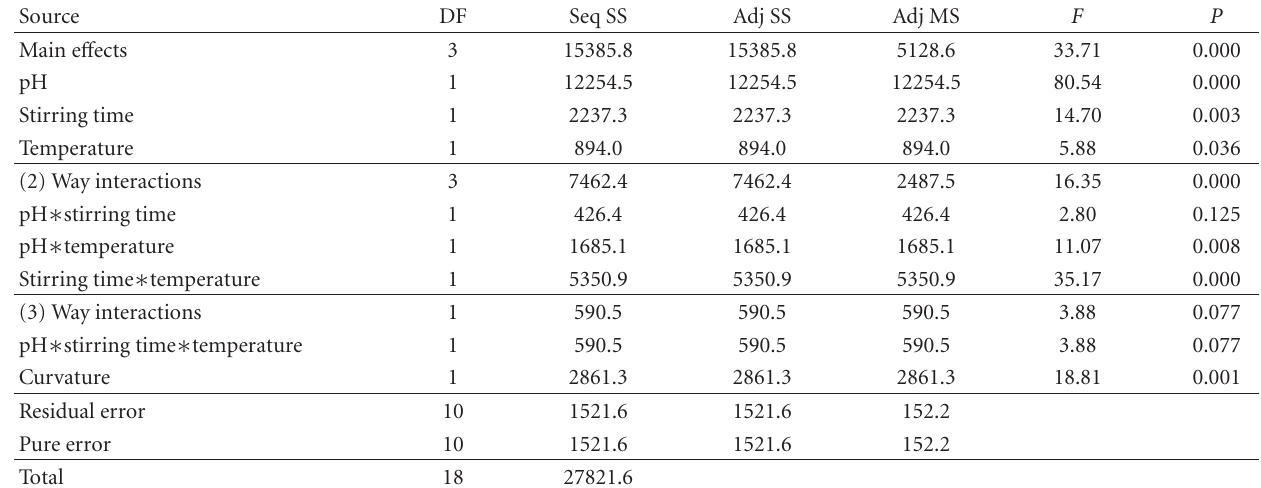
Table 4: Analysis of variance for concentration of leached